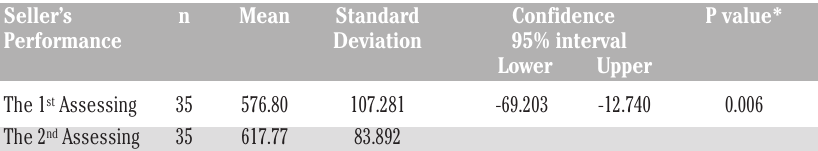
Table 2. The difference of the seller’s performance in food higiene and sanitation manage- ment between the first and the second assessing by cadres in Mokoau Health Care Centre in